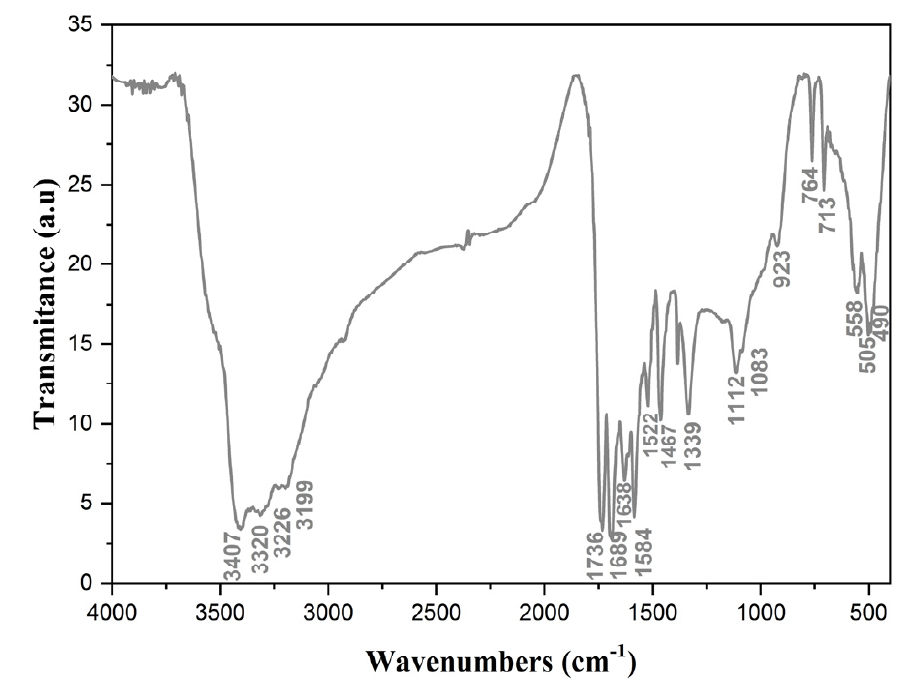
Figure 6. Infrared spectrum of (C 2 H 7 N 4 O) 2 BiCl 5 recorded at room temperature. In the high wavenumber region of the IR spectrum (2500–3500 cm − 1 ), the strong inten- sity peak corresponds to the stretching vibrations of NH 2 and NH groups (3407, 3320, 3226, and 3199 cm − 1 ). The strong hydrogen-bond interactions involving the amino groups (with lengths ranging from 2.734 to 3.524) are indicated by the broad nature of this band. At 1736 and 1584 cm − 1 , the -NH 2 bending modes were identified. The amino groups relating to the guanidinium ion fragment, (NH 2 ) guanidine, have a higher frequency than the primary amine, (NH 2 ) belonging to the ureic group, which has a lower frequency [23]. The band identified at 1689 cm − 1 was attributed to the stretching vibrations of the carbonyl group, υ (CO). The two amino groups show two distinct bands ascribed to the rocking vibrations at 1112 and 1083 cm − 1 , which are associated with the amino groups of the guanidine moiety and the primary amino group of the amide, respectively. Furthermore, as shown in the similar spectrum of guanidine, the band at 1339 cm − 1 has been assigned to the bending vibration of the amine, δ (NH) [26]. Stretching ν (CN) of the amide group, a characteristic band for primary amides in this spectral region, has been assigned to the band at 1467 cm − 1 . The vibrational bands located at 1638, 1522, and 923 cm − 1 have been attributed to the char- acteristic vibrations of guanidine skeletal modes, which agree with the previously reported spectra [23–26]. The bands recorded at 490, 505, 584, 713, and 764 cm − 1 were assigned to the mixed ρ (NCN), υ CN, and ω (NH 2 ) vibrations of carbamoylguanidinium cations